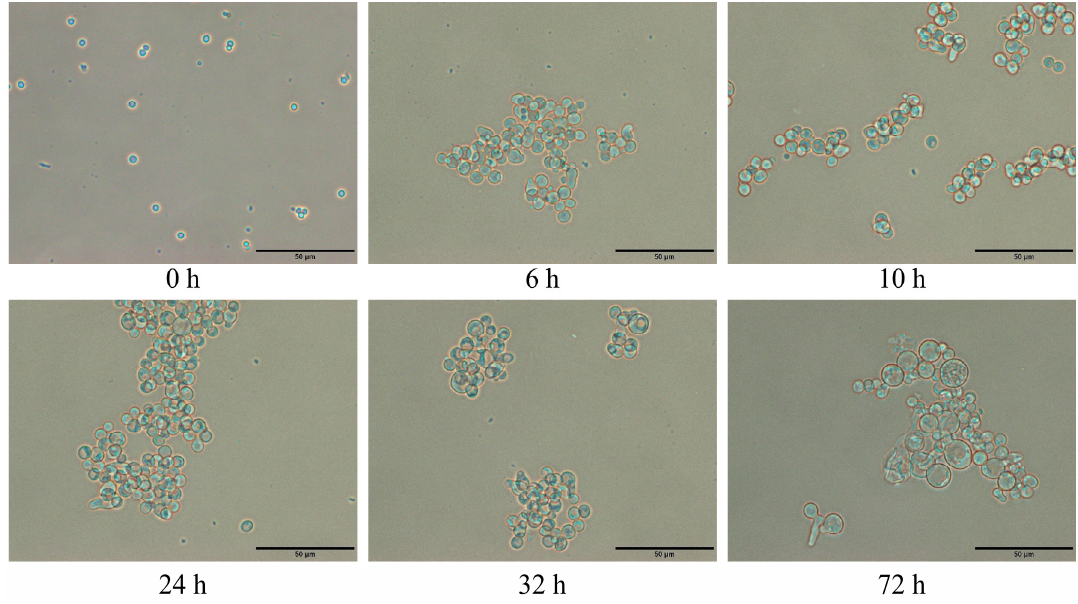
Figure 7. Aspergillus culture showing morphology changes when treated with mAb 1D2 after cul- turing for 6 h. After Aspergillus conidia were cultured for 6 h, most of the Aspergillus conidia were swollen, and some showed early germ tubes. When mAb 1D2 was added (6 h), conidia morphology changes were observed at the 10th, 24th, 32nd and 72nd hour of incubation. There was no significant development in germ tubes, but conidia became more swollen by 72 h. Scale bar represents 50 µm. Table 1. The diameters of the swollen conidia ( n = 30) over time.